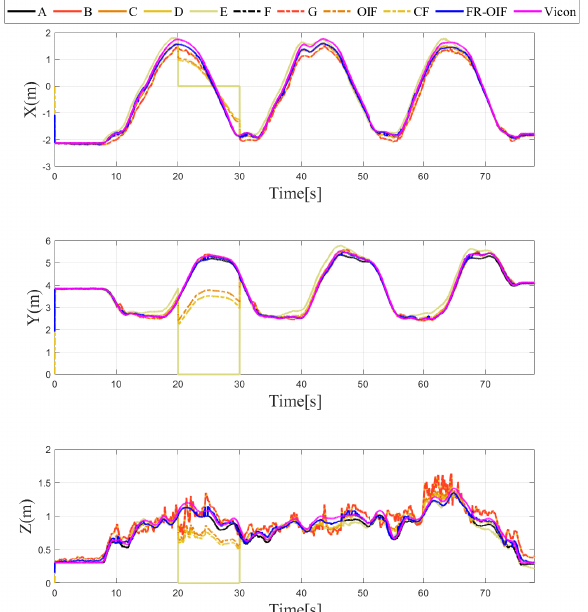
Figure 6. Estimated positions along ‘X-Y-Z’ components obtained from intermediate nodes ( A , . . . , G ) and FR-OIF, compared with CF, OIF and the ground truth. The evaluation is carried out in presence of temporal fault appearing from LIO (Case-1). Except the fused position obtained from FR-OIF all the estimated positions deviated during 20–30